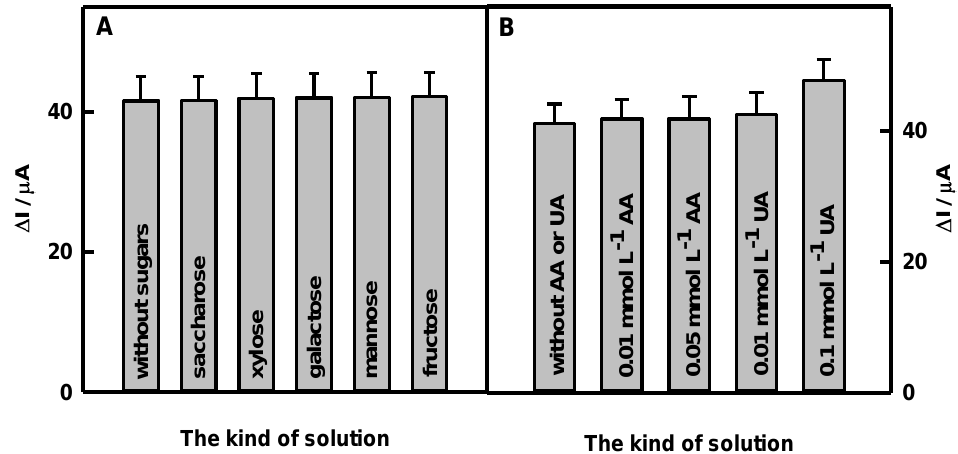
Figure 6. The influence of 1.0 mmol L − 1 sugars ( A ) and electroactive species ( B ) on the current responses of the glucose biosensor based on the Ppy/GOx/DGNs/GR electrode in the presence of 10.0 mmol L − 1 glucose. Enzymatic polymerization was performed for 22 h; current responses were registered in the presence of 6 mmol L − 1 PMS at +0.3 V vs. Ag/AgCl/KCl (3 mol L − 1 ) .